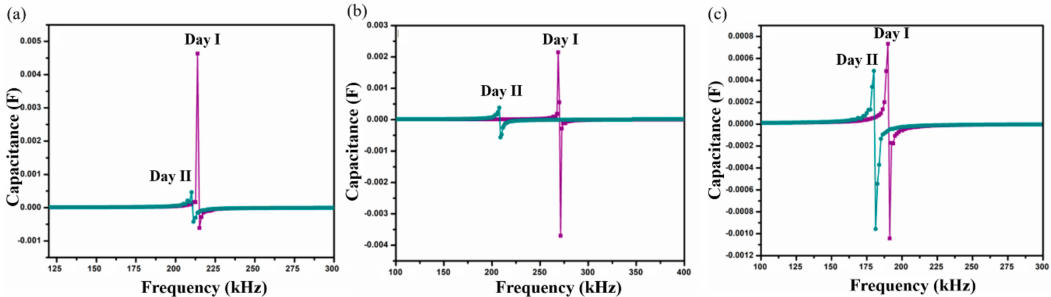
Figure 6. Shift in SRF on two consecutive days for samples ( a ) SnIn5, ( b ) SnIn10 and ( c ) SnIn15 in S. aureus